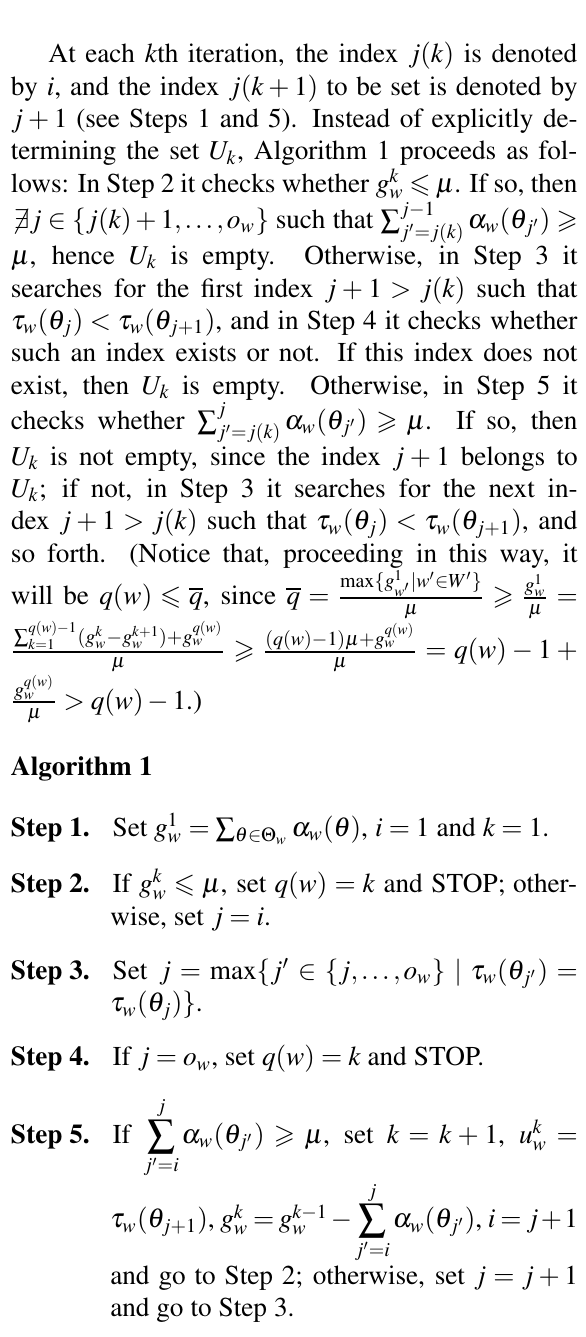
ing Algorithm 1. We have taken M k